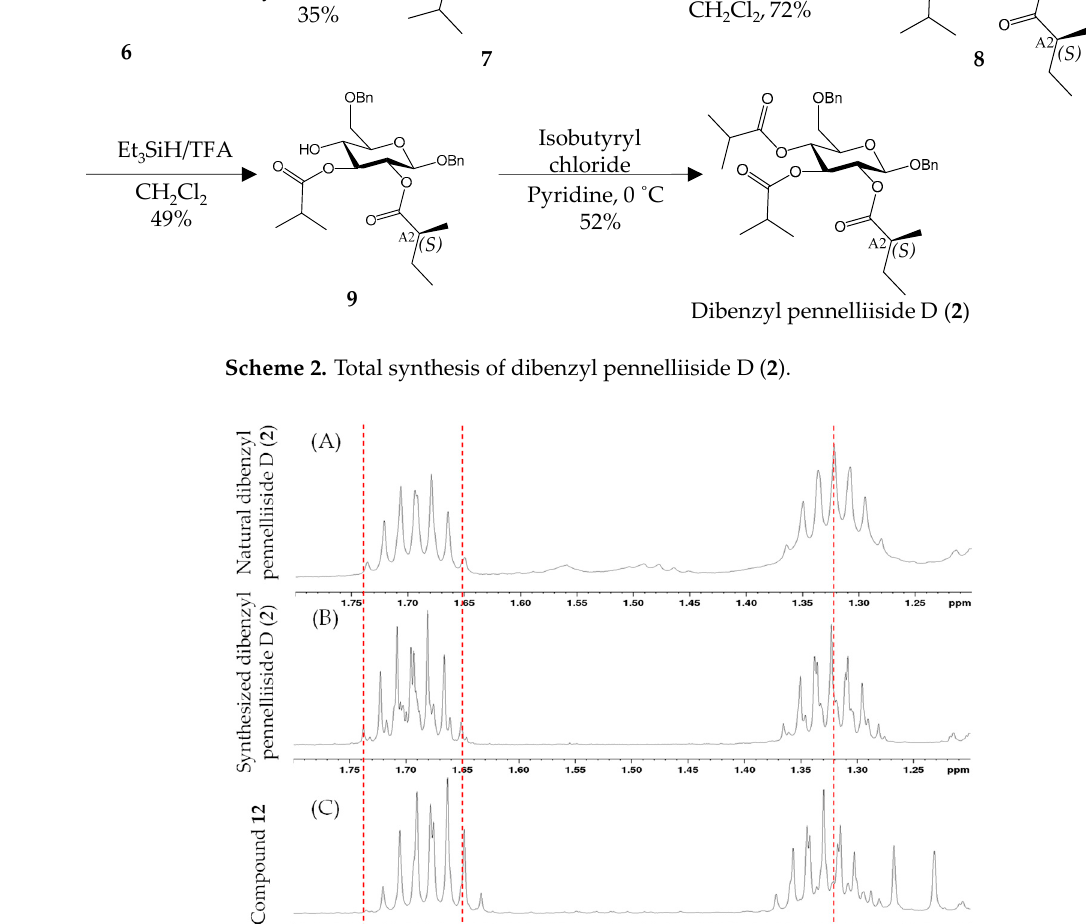
Scheme 2. Total synthesis of dibenzyl pennelliiside D ( 2 ).